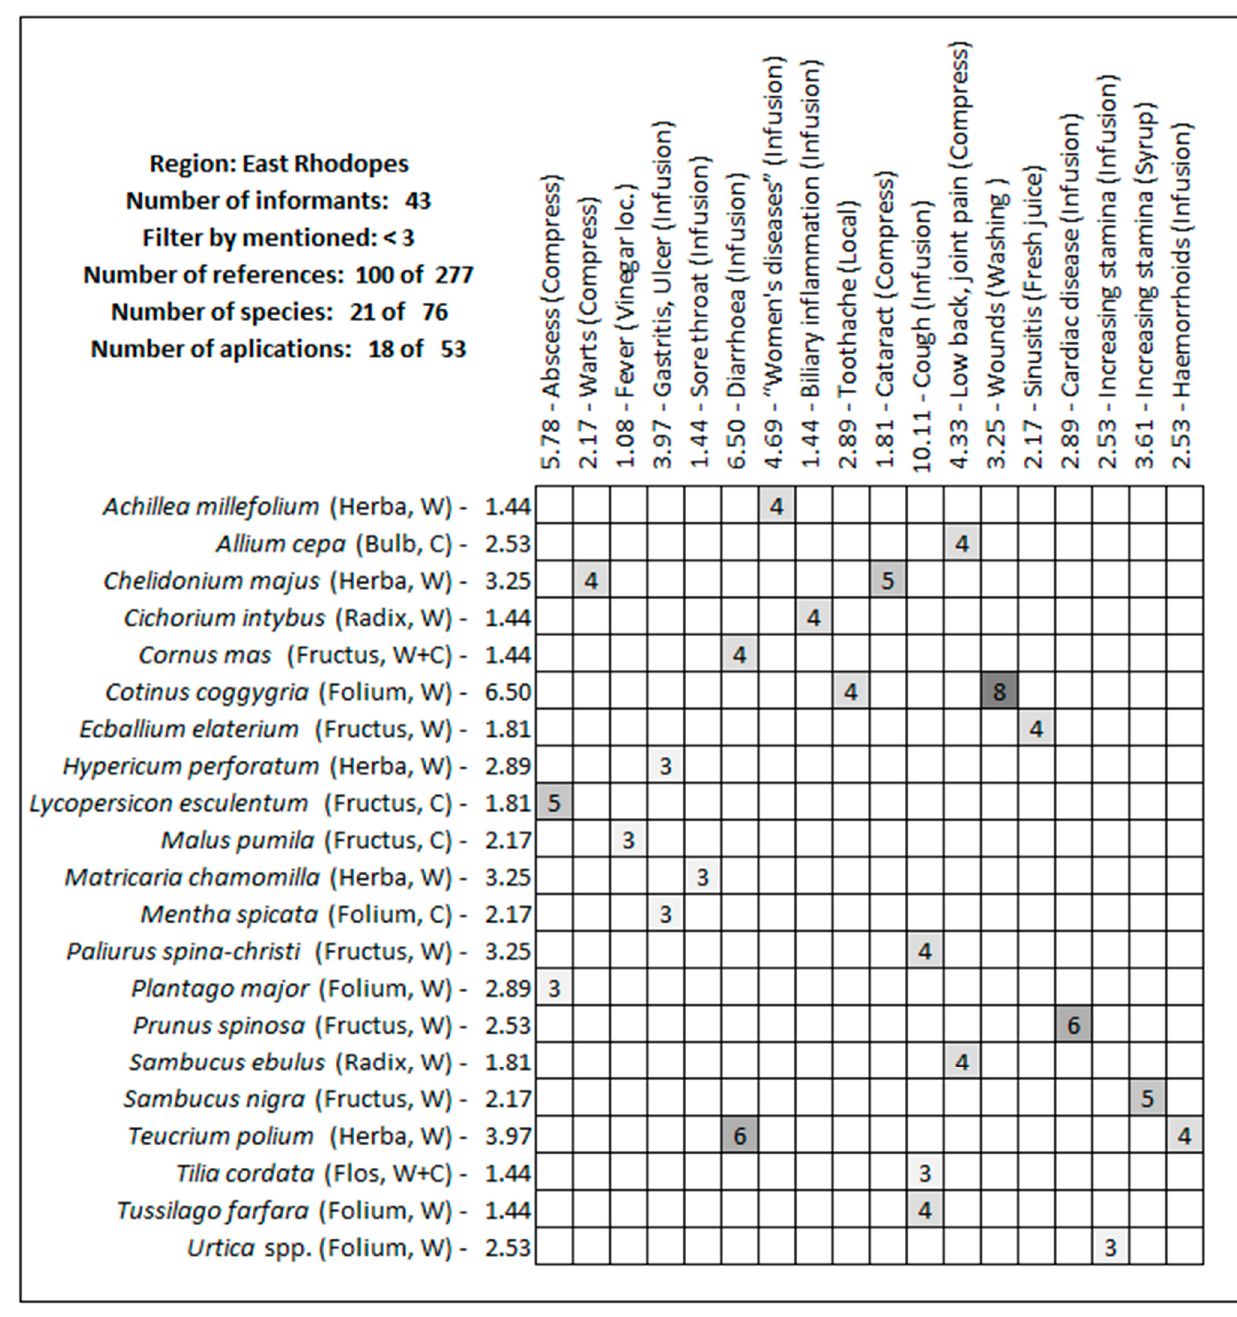
Figure 9. Nomogram of the medicinal plants for human use (at Σ U > 2) in the East Rhodopes, Legend: abscissa/horizontal axis of the nomograms depicts the conditions for which the informants apply the medicinal plants, as well as the way of processing the plant raw material; ordinate vertical axis shows the medicinal plants Genus species (used part, wild/cultivated)—UV (%).